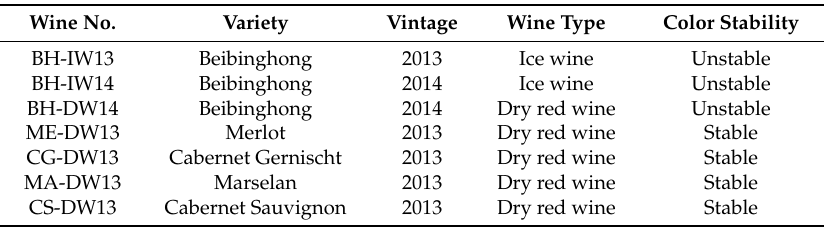
Table 1. Sample identity and details